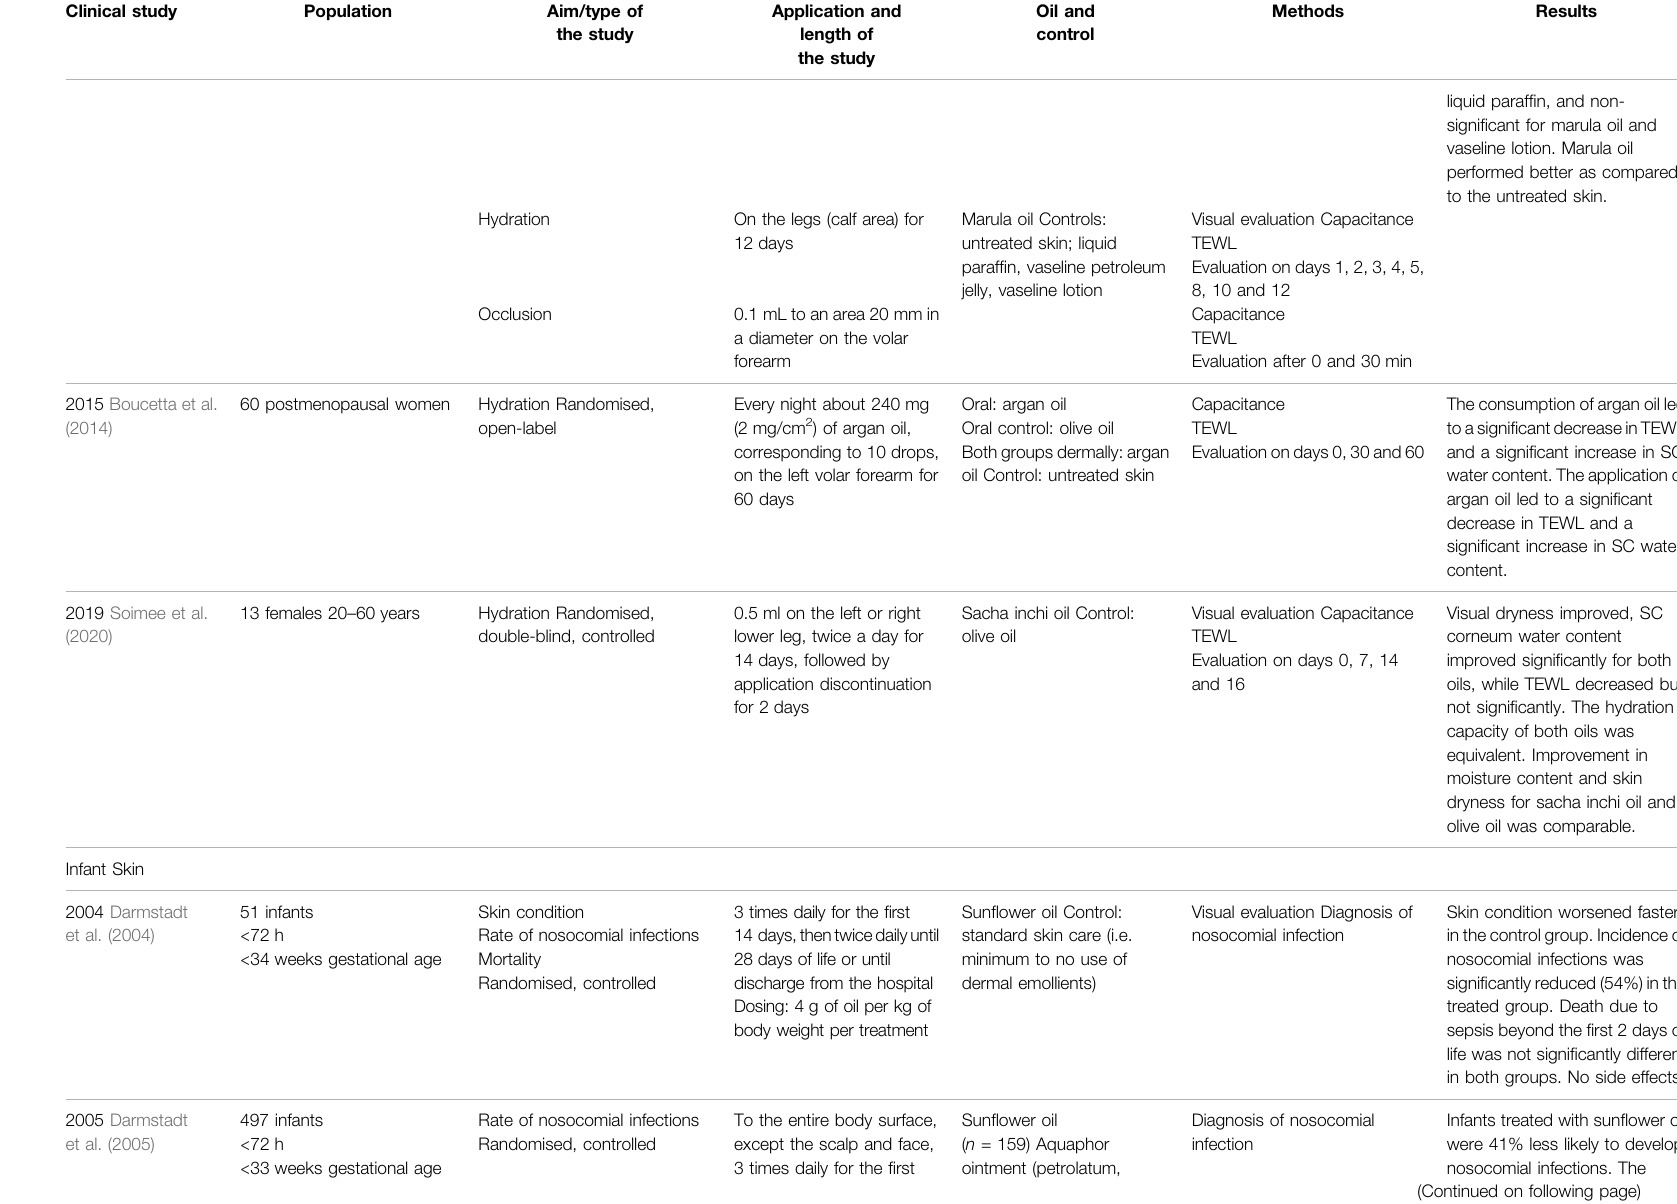
TABLE 4 | ( Continued ) Clinical studies evaluating the dermal effects of vegetable butters and oils. AD — atopic dermatitis, GC — gas chromatography, MC — molluscum contagiosum , SA — Staphylococcus aureus , SC — stratum corneum, SG — striae gravidarum, SLS — sodium lauryl